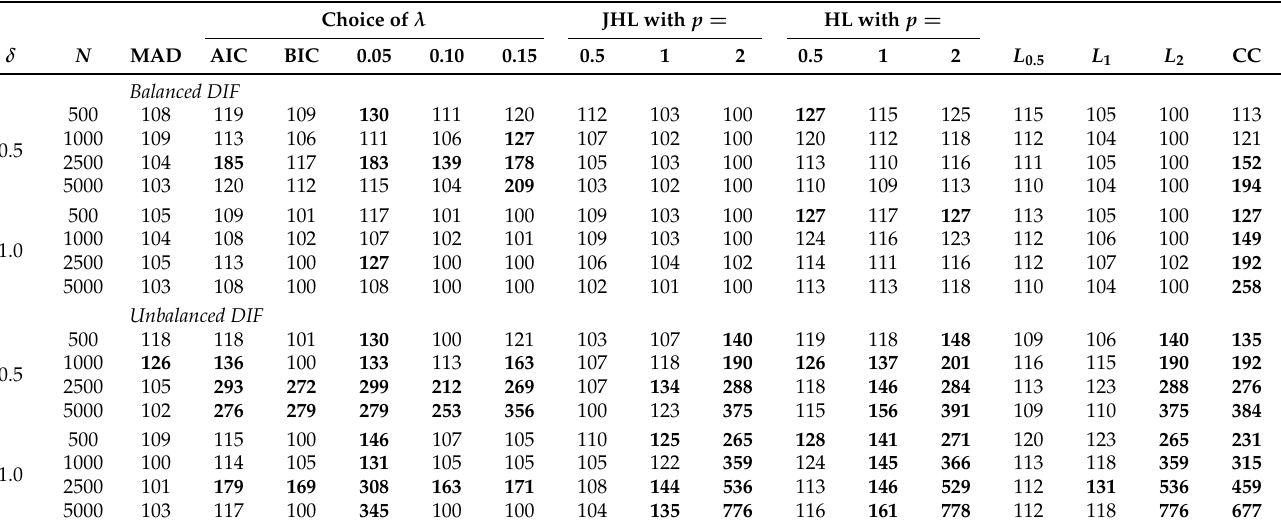
Note. MAD = robust linking using the MAD statistic; Choice of λ = method or valuze for determining the regularization parameter λ ; JHL = joint Haberman linking using joint item discriminations; HL = Haberman linking using group-specific item discriminations; L p = linking employing the unweighted L p loss function with p = 0.5, 1.0, or 2.0 using joint item discriminations; CC = concurrent calibration assuming invariant item parameters; Absolute biases larger than 0.03 are printed in bold. Table 5. Simulation Study 2: Relative root mean square error (RMSE) of estimated group means for balanced and unbalanced DIF effects as a function of the size of DIF effects δ and sample size N . Choice of λ JHL with p = HL with p